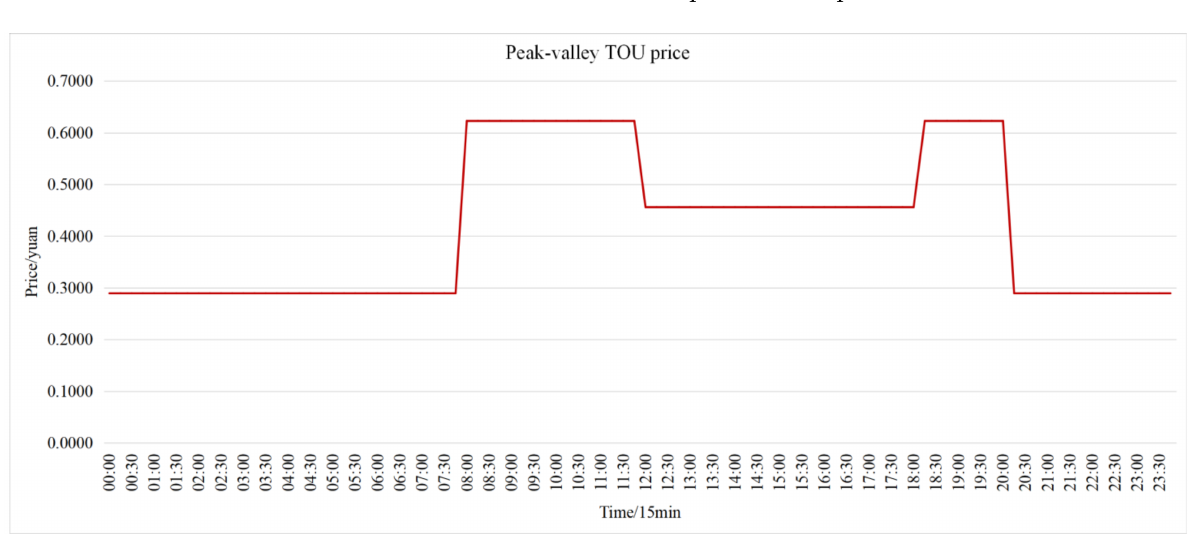
Figure 4. Peak-valley TOU price curve of typical province.